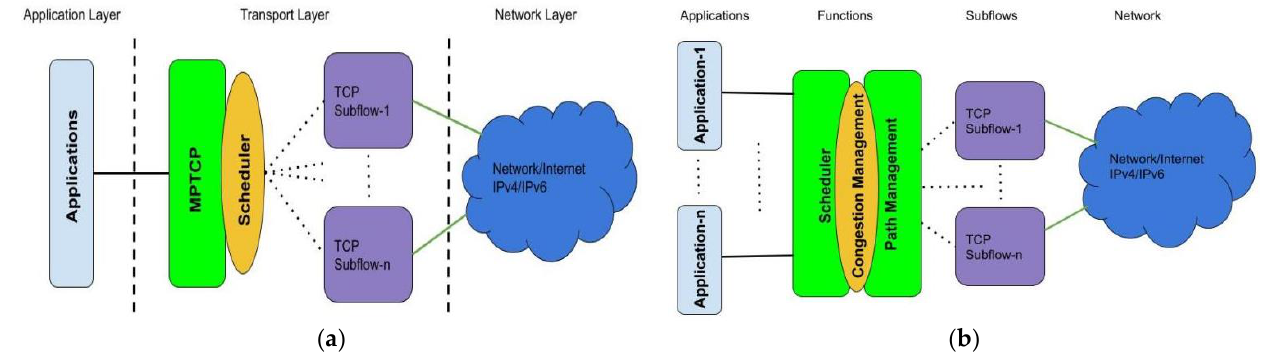
Figure 2. The architecture of MPTCP. ( a ) Protocol stack. ( b ) Functions.